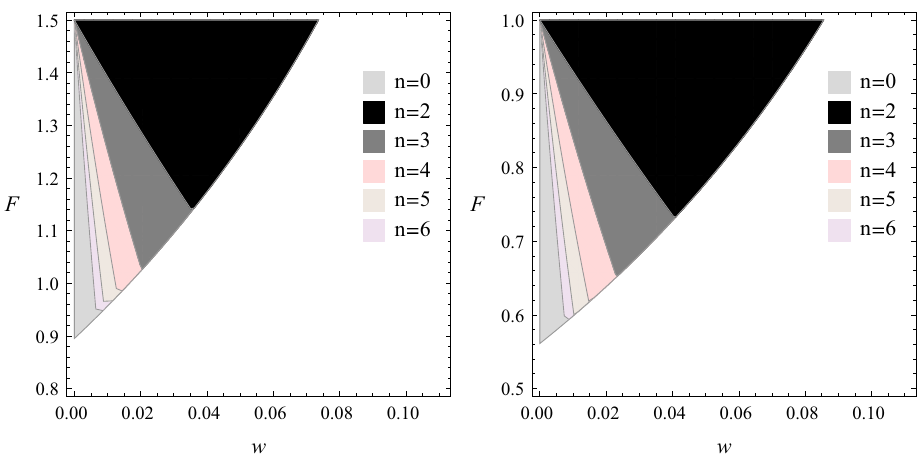
Fig. 1 The stability regions in the F – w plane under homogeneous and inhomogeneous perturbations with n taken to be n = 0 , 2 , 3 , 4 , 5 , 6. n = 0 corresponds to the results from homogeneous perturbations. The left panel is plotted with ρ s = 15 and κ = 2 κ =